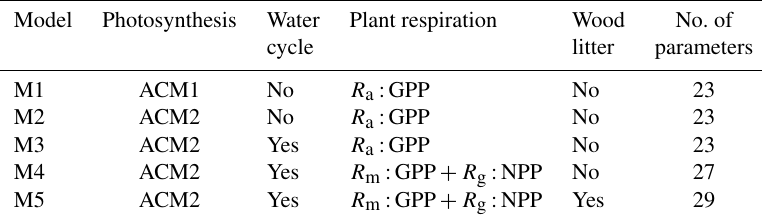
Table 1. Summary information of process representations and total number of calibrated parameters of the different Data Assimilation Linked Ecosystem Carbon (DALEC) models. Model complexity increases from models M1–5. ACM is the Aggregated Canopy Model used to predict photosynthesis (GPP), with ACM1 the simplest version and ACM2 more complex with links to water balance. Plant respiration ( R a ) can be determined as a simple ratio of GPP or by separate maintenance ( R m ) and growth ( R g ) components. Model Photosynthesis Water Plant respiration Wood No. of cycle litter parameters M1 ACM1 No R a : GPP No 23 M2 ACM2 No R a : GPP No